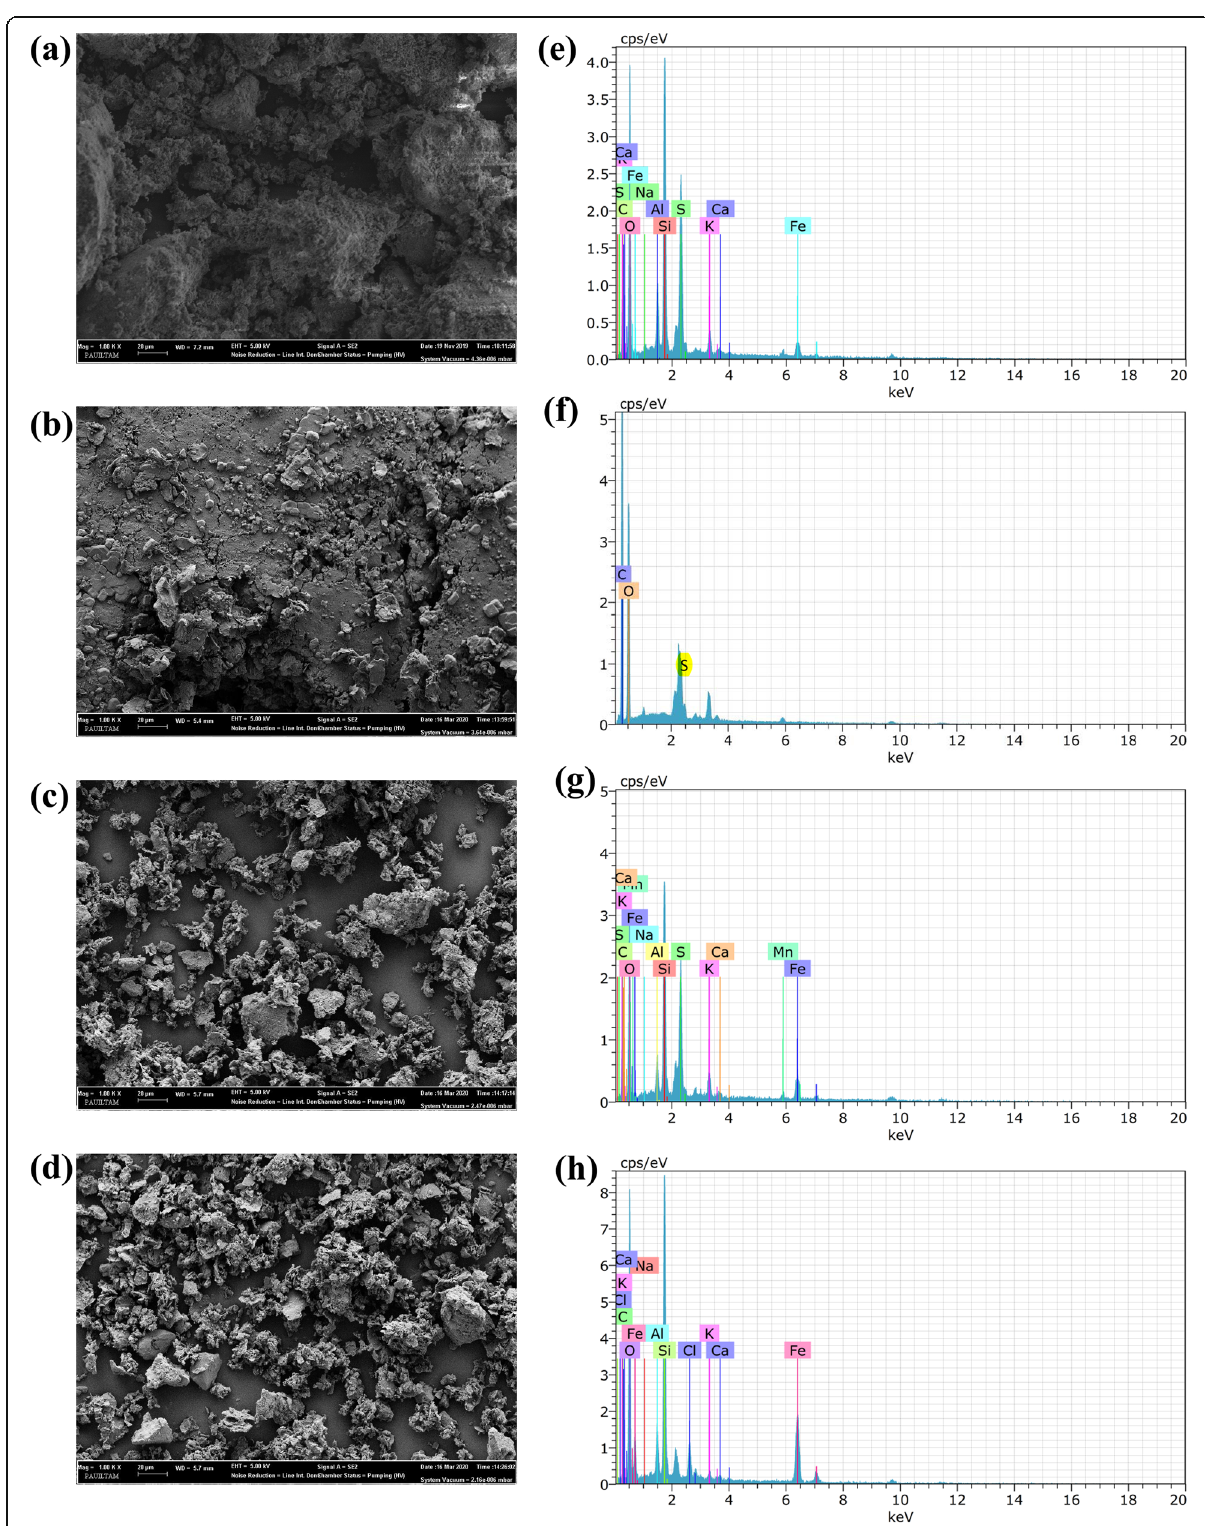
Fig. 2 SEM images of a FeZ, b GO, c GOFeZA, and d GOFeZB with magnification of 1000 and EDS spectrum of e FeZ, f GO, g GOFeZA, and h